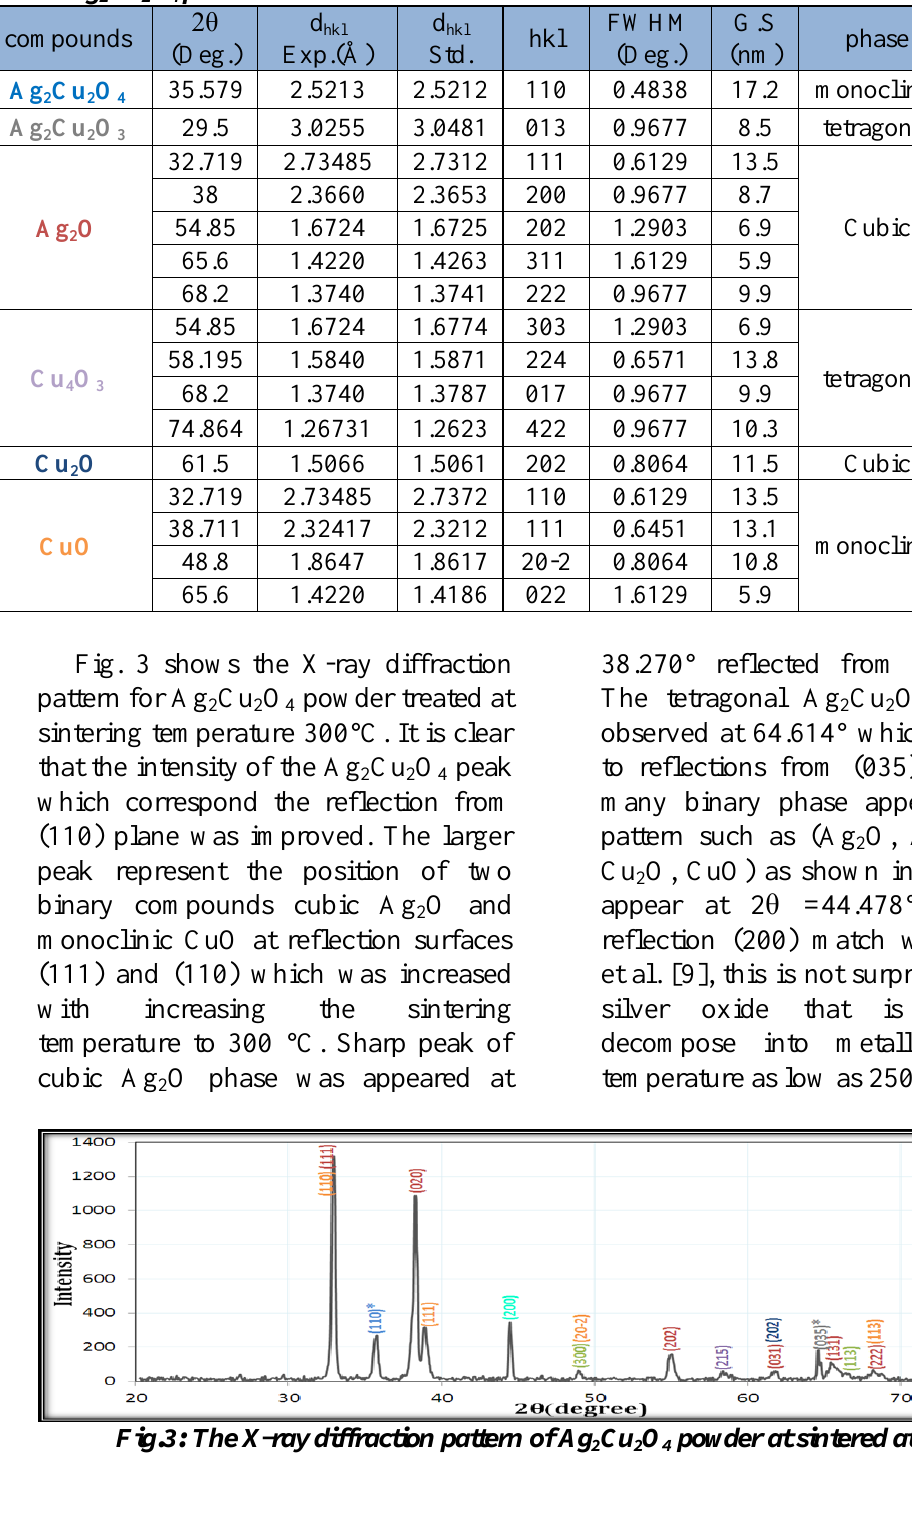
G.S phase card No. (Deg.) (nm)